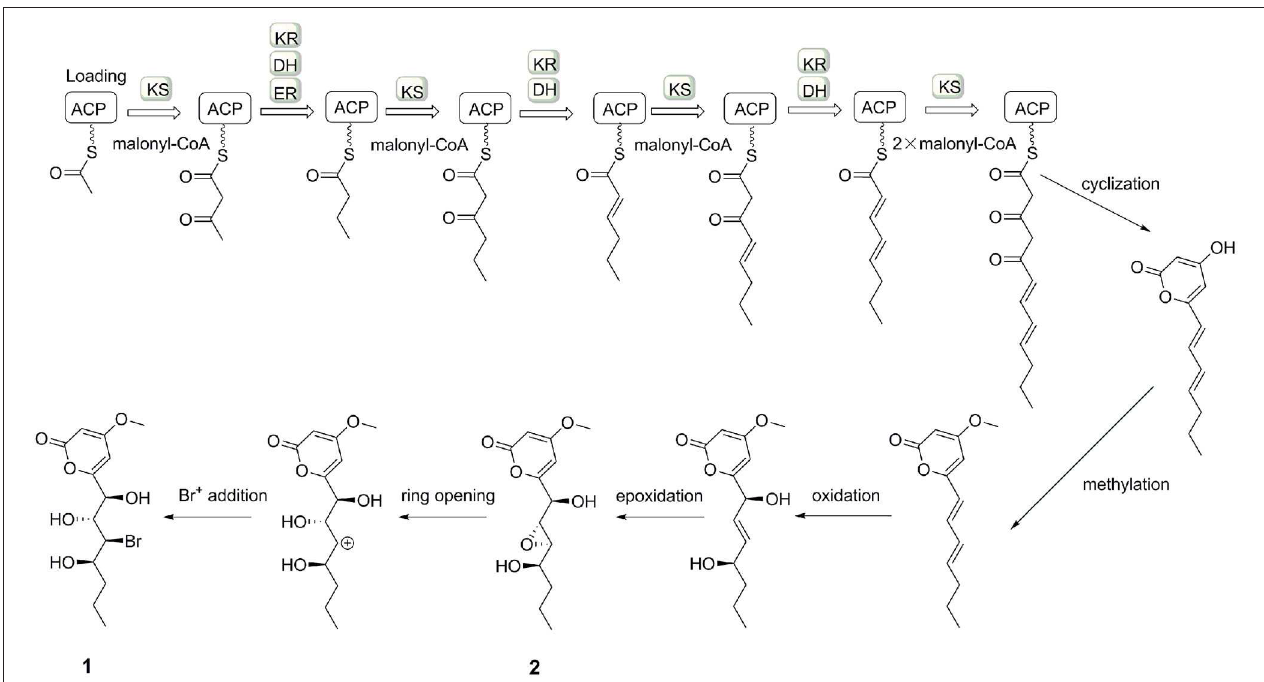
FIGURE 8 | The possible biosynthesis of induced compounds 1 and 2